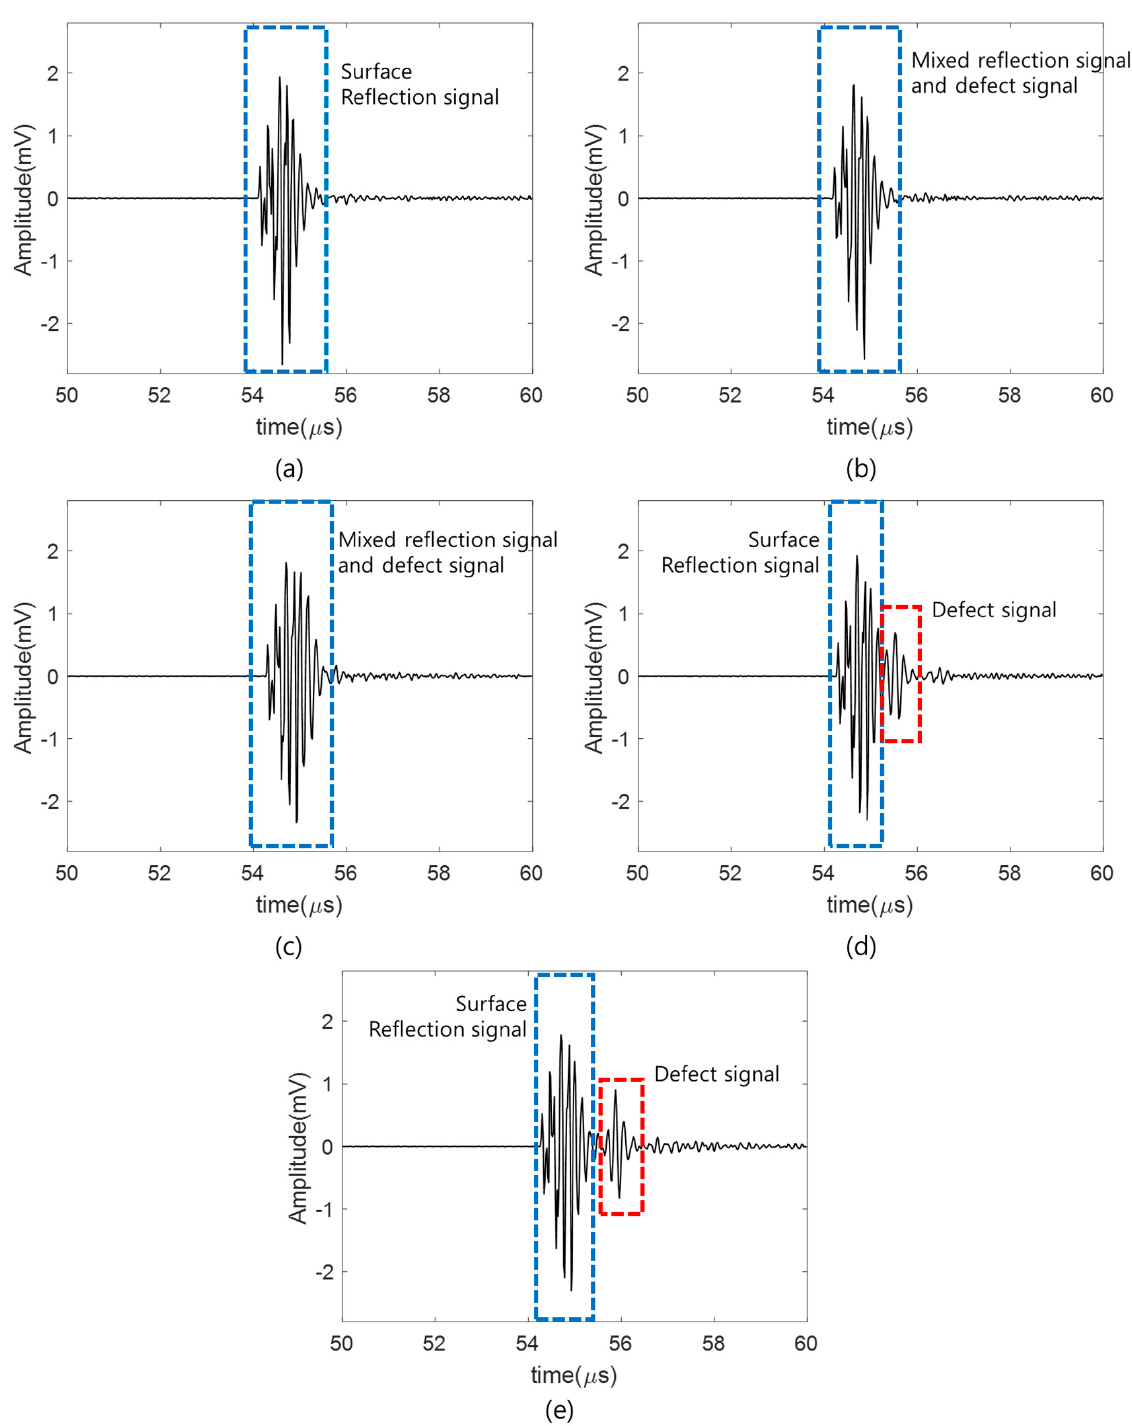
Figure 5. Ultrasonic A − scan signals of the standard specimen: ( a ) without defects; with defects below the surface at depths of ( b ) 1 mm, ( c ) 2 mm, ( d ) 3 mm, and ( e ) 4 mm.